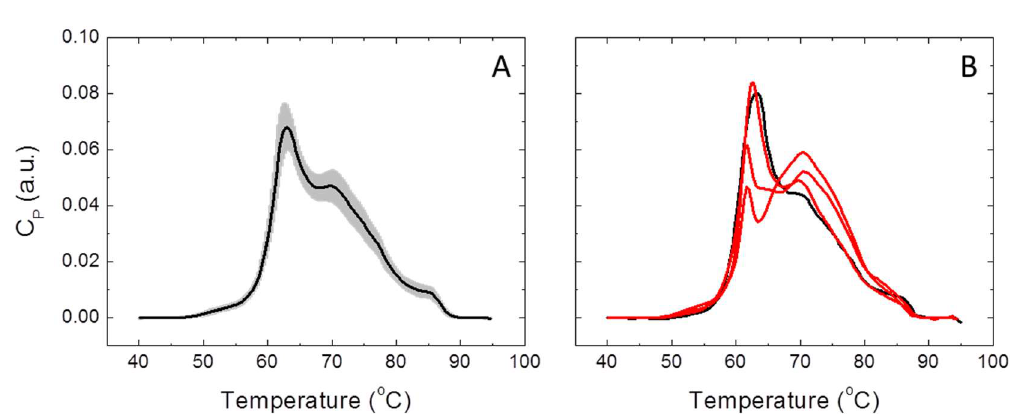
Figure 1. Thermal liquid biopsy (TLB) serum thermograms for healthy control (HC) and lung cancer patient (LCP) individuals. ( A ) Average TLB thermogram calculated with all subjects belonging to the HC group (continuous line) is shown together with the standard deviation of the thermograms at each temperature (shaded region). ( B ) TLB thermogram for a healthy subject (black line) compared to three thermograms from lung cancer patients (red lines).